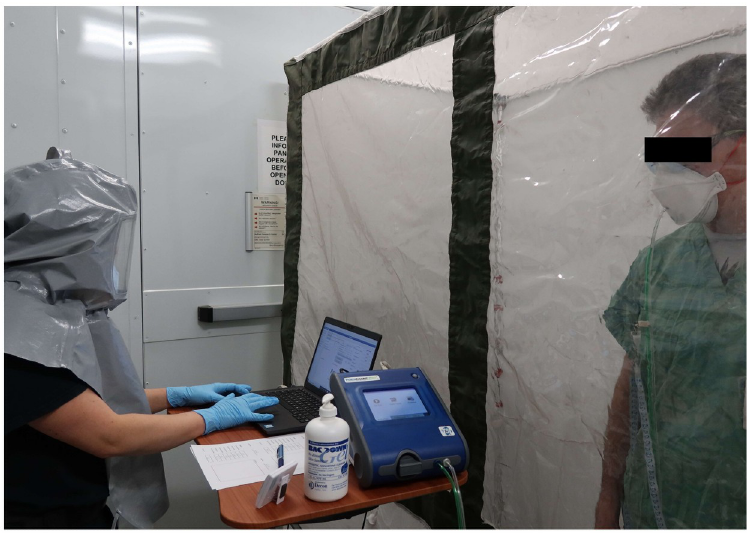
Fig 3. Total inward leakage test being performed on the 3M ™ model 9210 N95 FFR. The Sampling probe for the TSI Portacount 8038 is shown to be connected to the respirator by use of a sampling probe supplied by TSI. The operator is shown to be wearing a loose-fitted PAPR and nitrile gloves as a health and safety precaution from working in close proximity to the test volunteers during the COVID-19 pandemic.